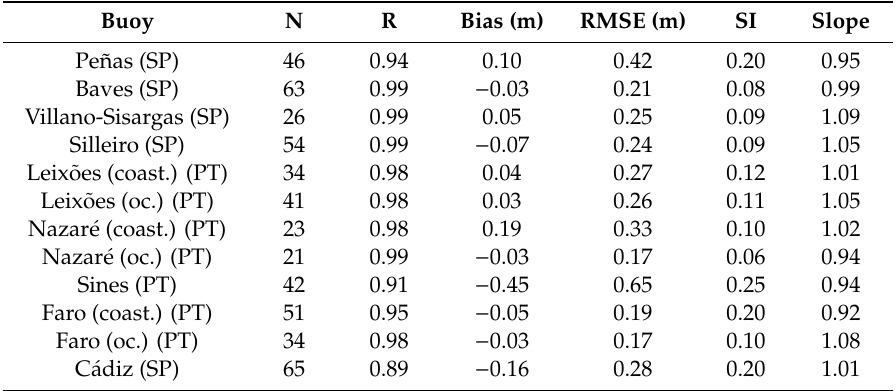
Table 5. Comparisons between SRAL and buoy SWH measurements. Statistics metrics: Correlation coe ffi cient (R), RMSE, bias, SI, and slope. N corresponds to SRAL-buoy SWH observation pairs. SP: Spanish buoys and PT: Portuguese buoys. Buoy